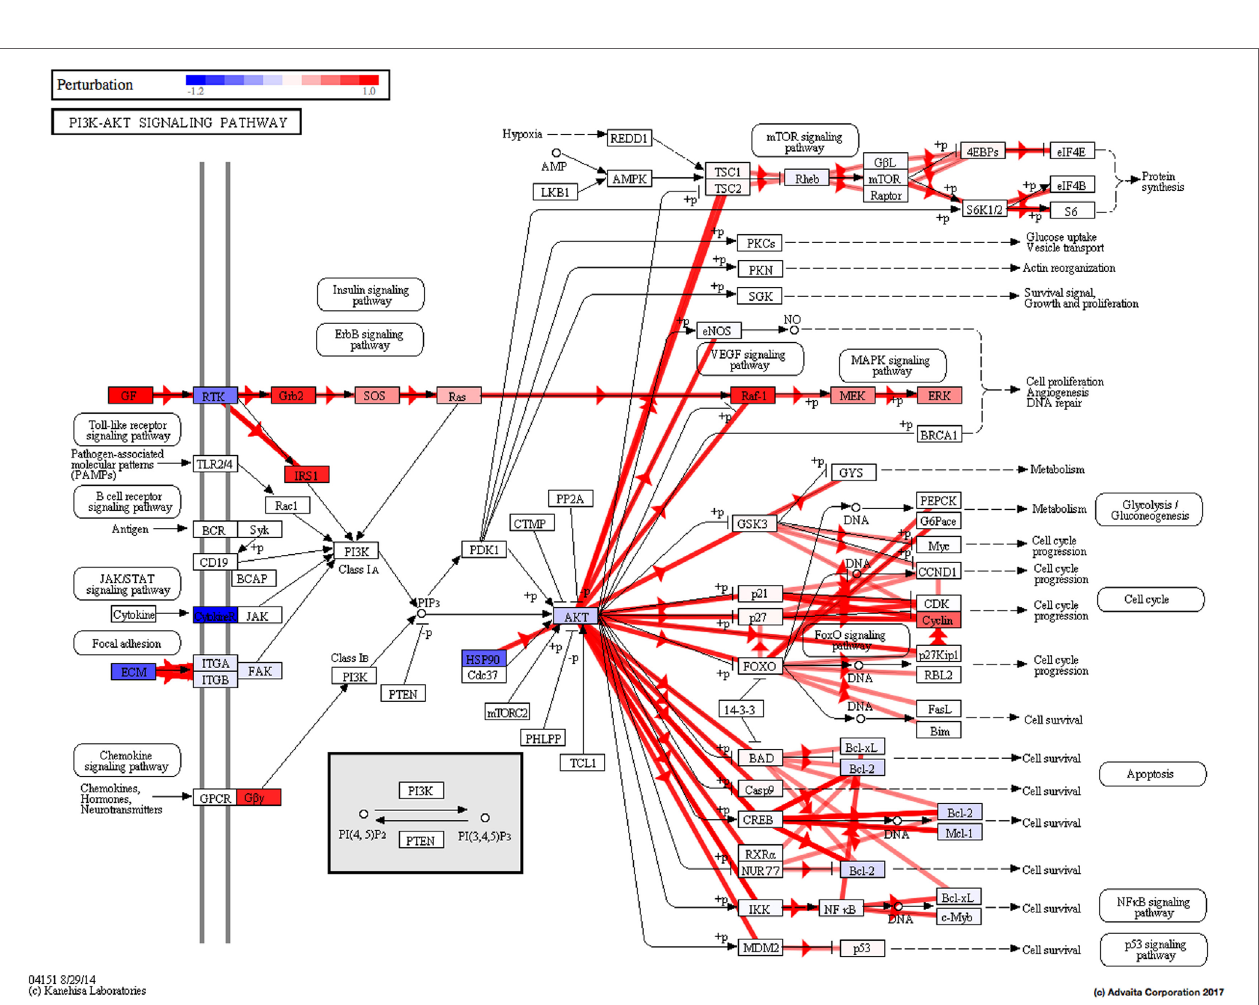
FigUre 6 | (a) Perturbation in extracellular matrix (ECM) receptor interactions in response to stimulation of osteoblasts with interleukin (IL)-6. Using Illumina’s iPathwayGuide, we evaluated the perturbation in ECM receptor interactions. Under inflammatory conditions, expression of ECM receptors aids in inflammatory cellular migration and adhesion. The diagram demonstrates a significant upregulation of ECM receptor interactions in response to stimulation of osteoblasts with IL-6. (B) Perturbation in ECM receptor interactions in response to resolvin E1 (RvE1) treatment after stimulation of osteoblasts with IL-6. The diagram demonstrates a significant downregulation of ECM receptor interactions in response to 100 nM RvE1 treatment after stimulation of osteoblasts with IL-6.